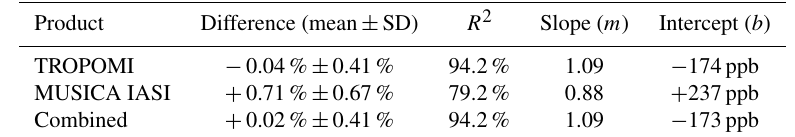
Table 3. Statistics based on the comparisons between satellite and TCCON data of the overall mean XCH 4 values obtained for the 14 TCCON sites of Table 1.